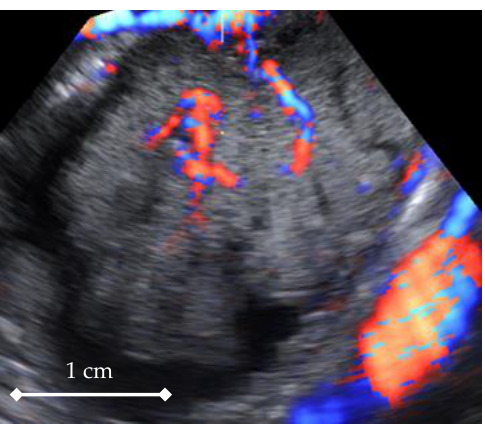
Figure 1. Schematic principle of creating a Spatio-Temporal Image Correlation (STIC) 4D record.